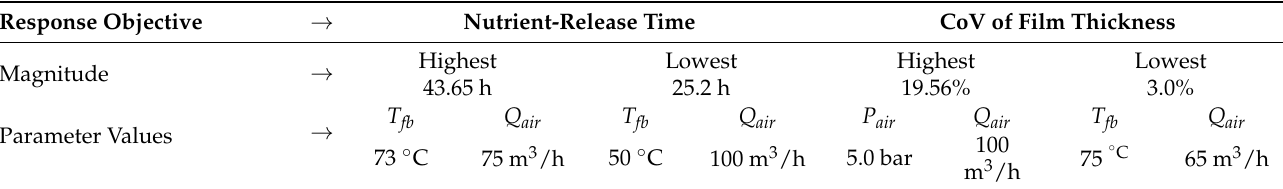
Table 6. Summary of the salient